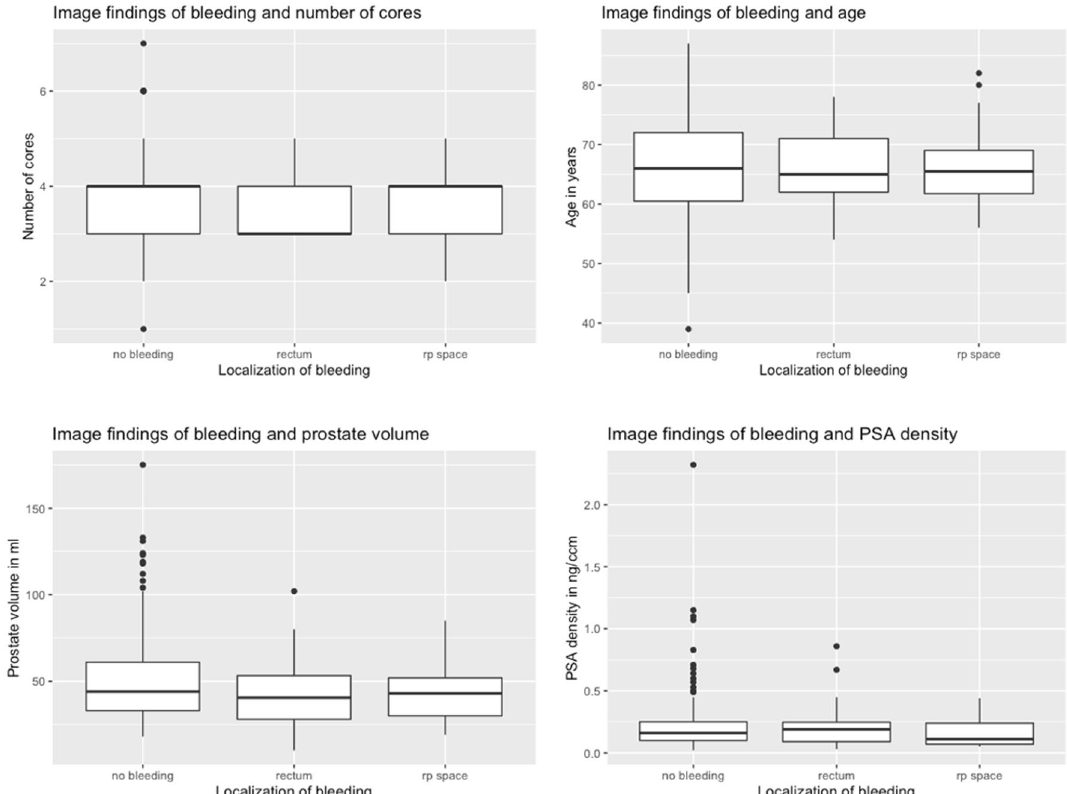
Figure 5. Correlation of bleeding and patient characteristics; image findings of bleeding and number of cores, age, prostate volume and PSA density, rp space rectoprostatic